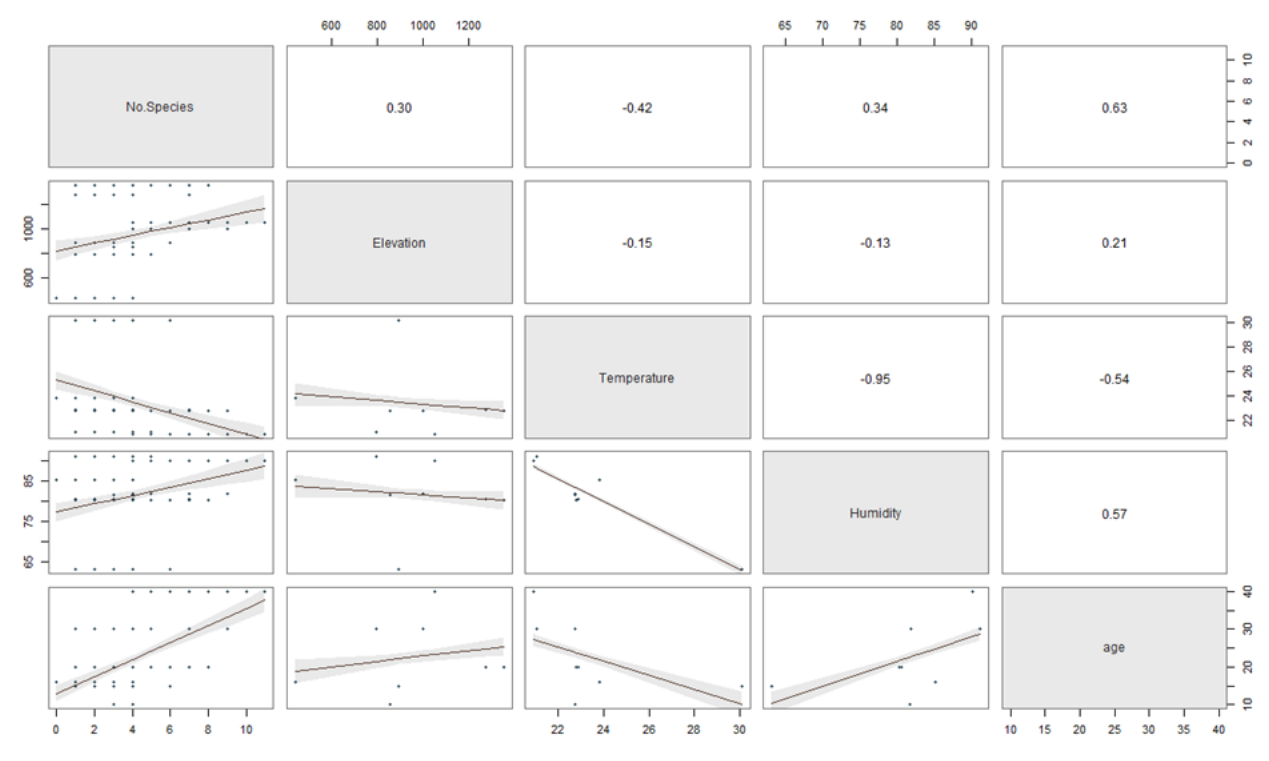
Figure 6. The scatter plot matrix describes the multiple regression between the stand-age, elevation, temperature, and humidity to the number of ambrosia beetle species.